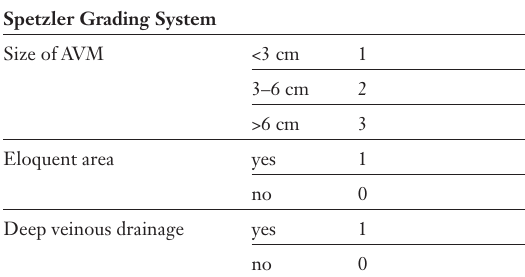
Spetzler Grading System of arterio- venous malforma- tion.